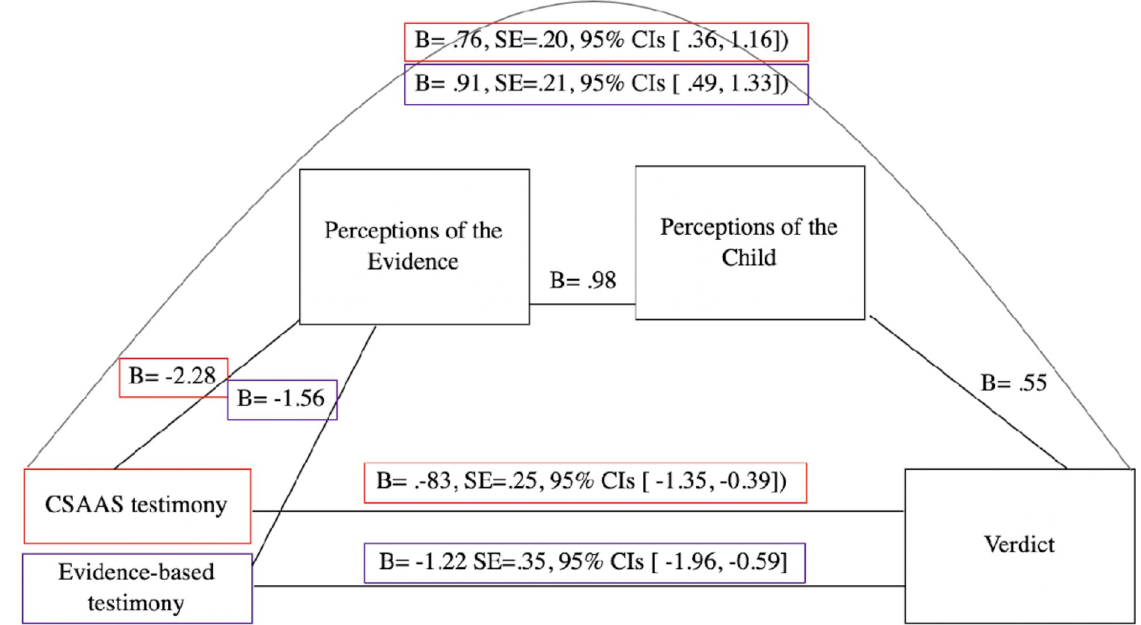
Fig 3. Exploratory mediation analysis for Study 2. Conceptual diagram of the exploratory serial mediation analyses in Study 2 depicting the relationship between Evidence-based Testimony and CSAAS testimony and verdicts when compared to Nonscientific experience-based testimony (the